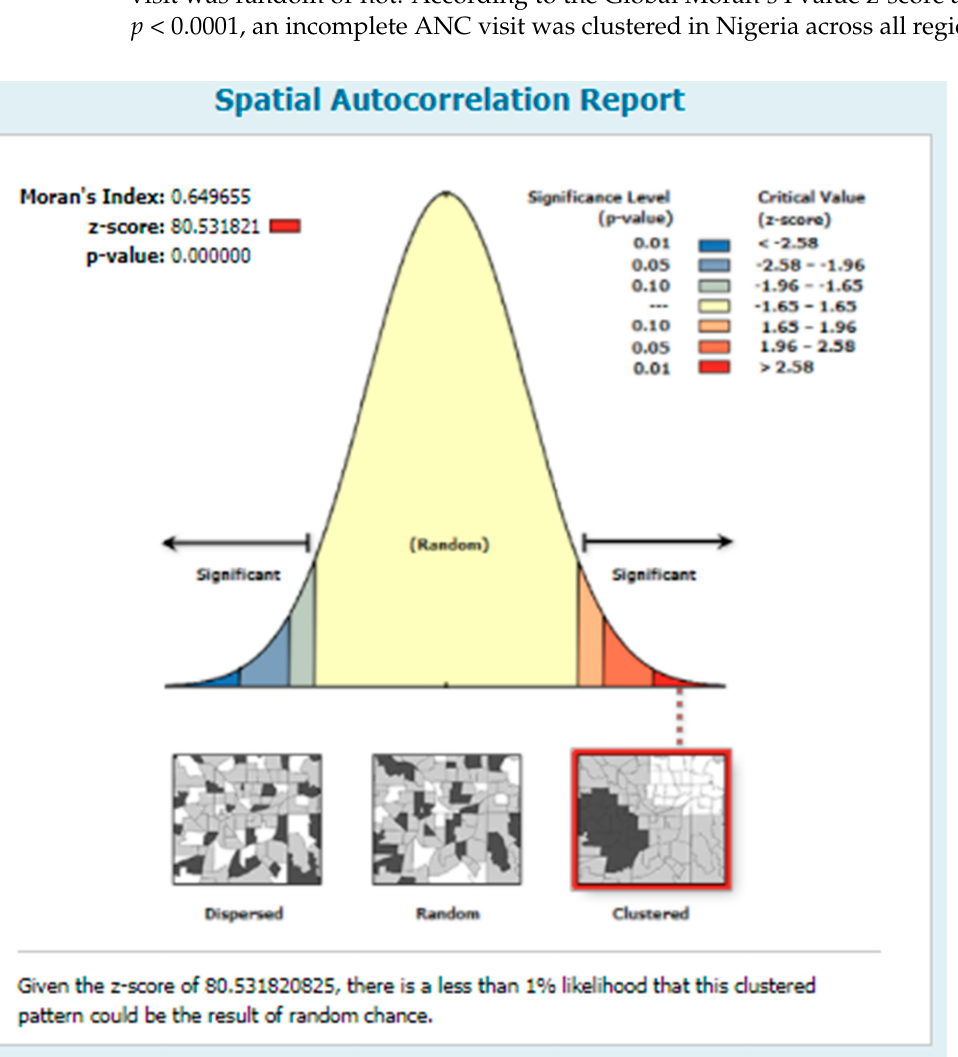
Figure 1. Spatial autocorrelation of incomplete ANC visits in Nigeria, 2018.